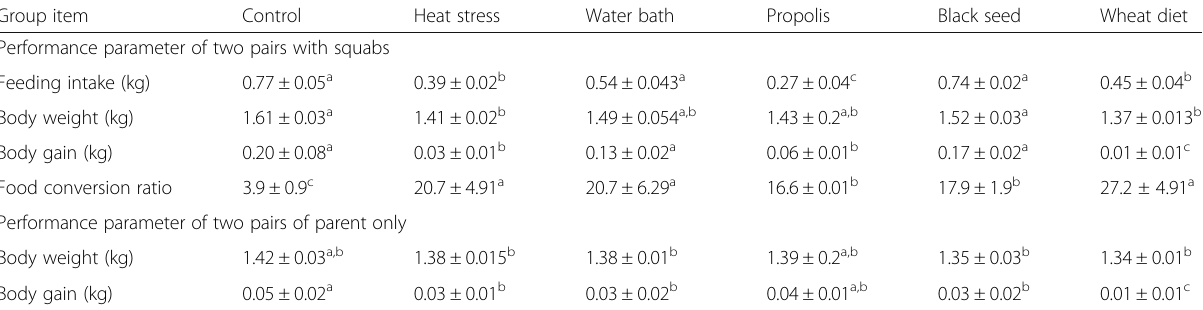
Table 4 Managerial and nutritional effect on performance parameter of two pairs of parent with or without squabs of heat stressed pigeon Group item Performance parameter of two pairs with squabs